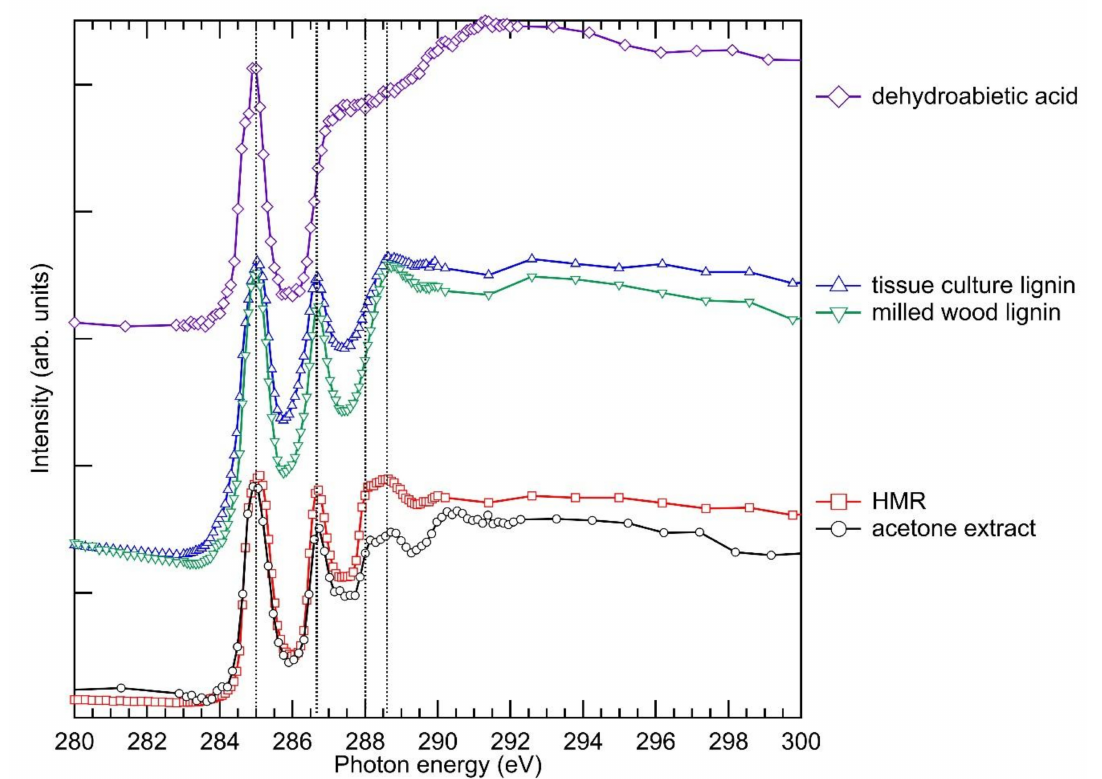
Figure 1. C 1s X-ray absorption spectra of the acetone extract of the knotwood (black line with circles), of hydroxymatairesinol (HMR, red line with squares), of the tissue culture lignin (blue line with triangles), of the milled wood lignin (green line with triangles) and of dehydroabietic acid (violet line with diamonds). The spectra of HMR and the tissue culture lignin have been adopted from Huttula et al.